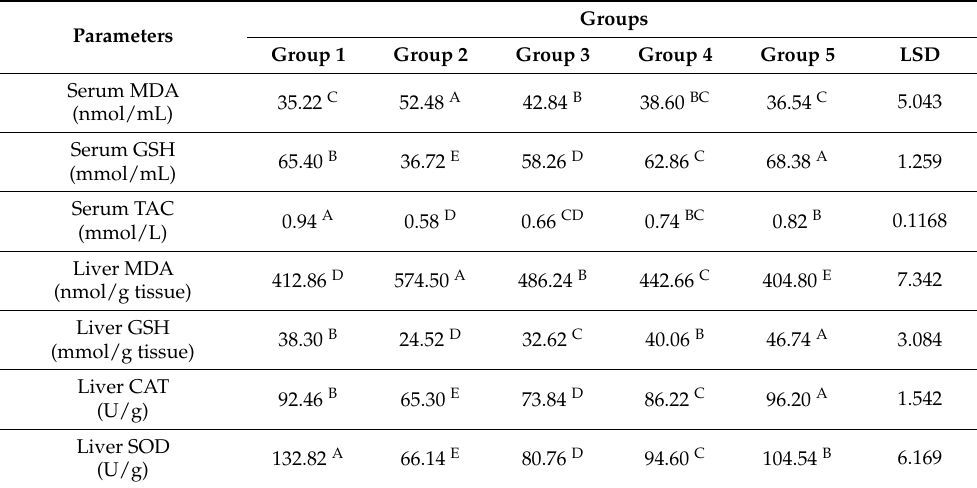
Table 6. Effect of a yogurt drink fortified with golden berry juice on serum MDA, GSH, and TCA and Liver MDA, GSH, CAT, and SOD levels in rats with